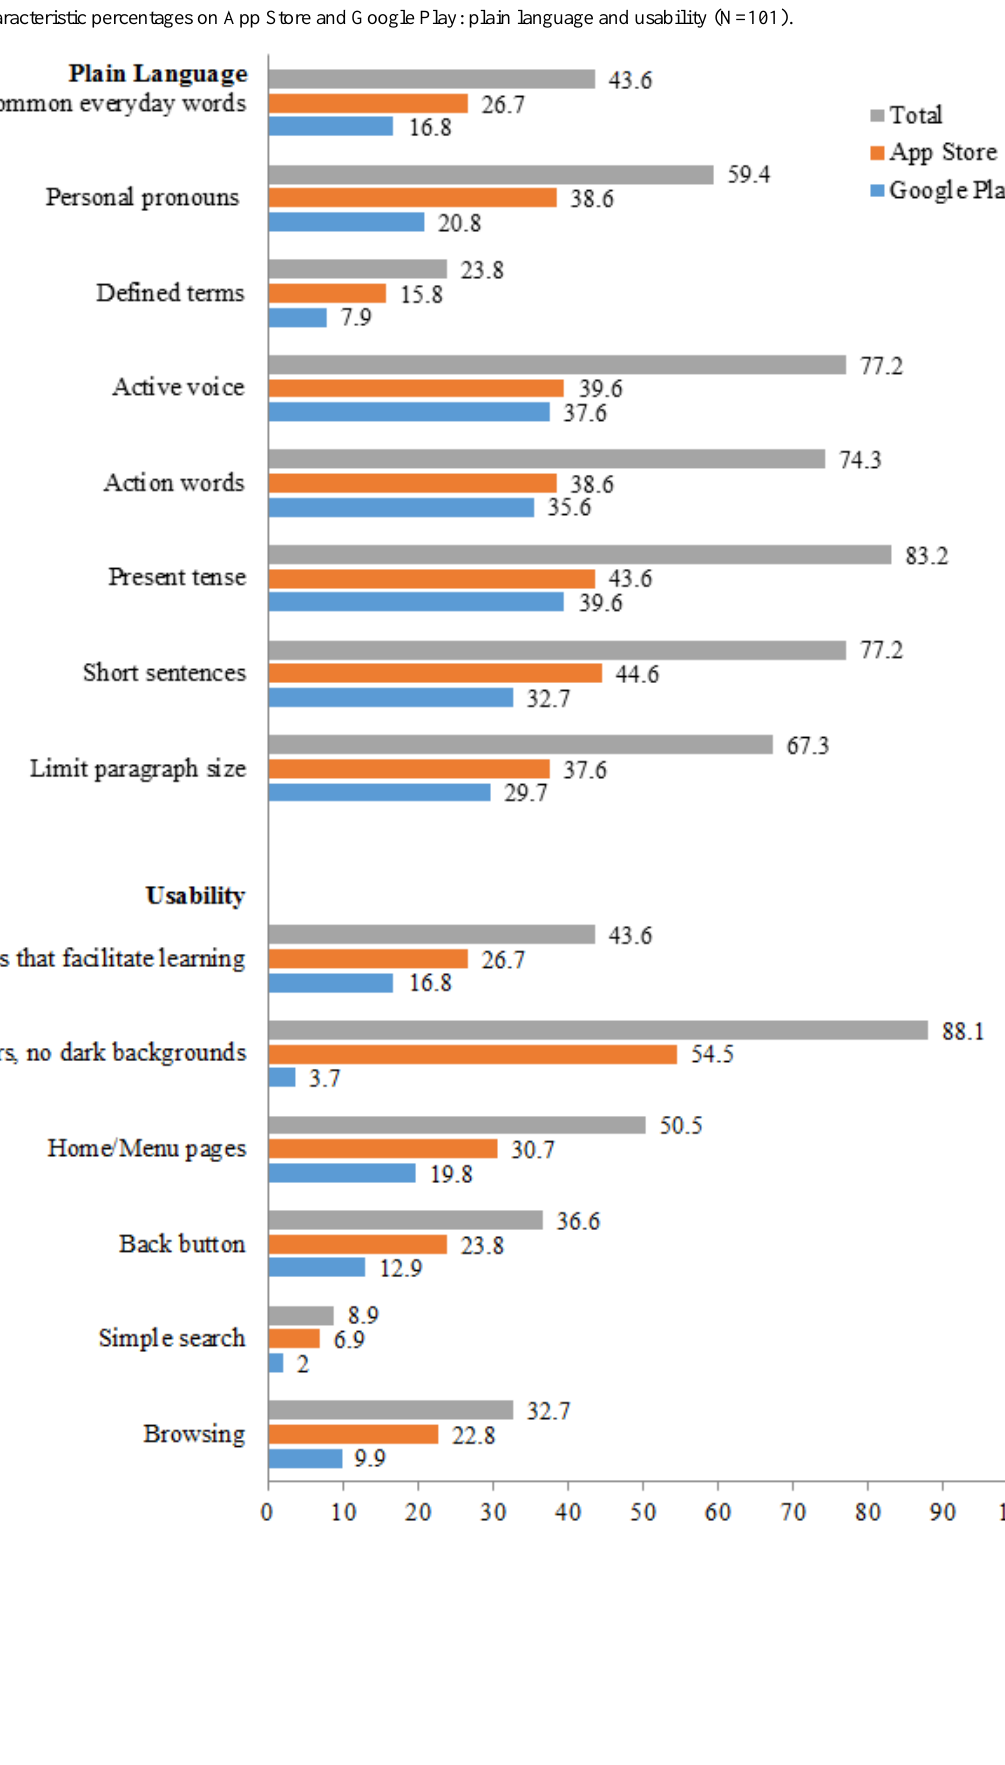
Figure 4. App characteristic percentages on App Store and Google Play: plain language and usability